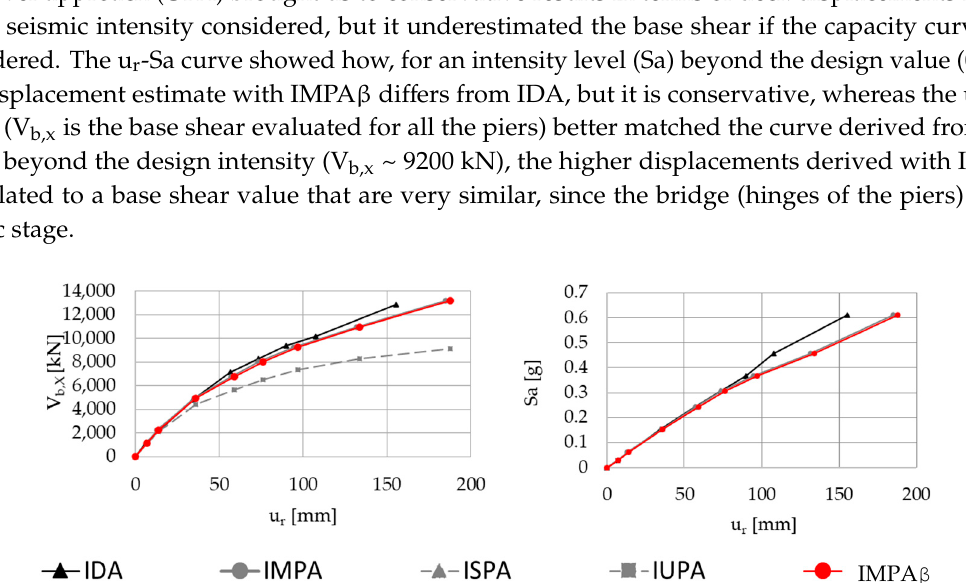
with IDA (maximum values of ur and Vb,x) or IMPA β (the design PGA was 0.35 g, corresponding to a